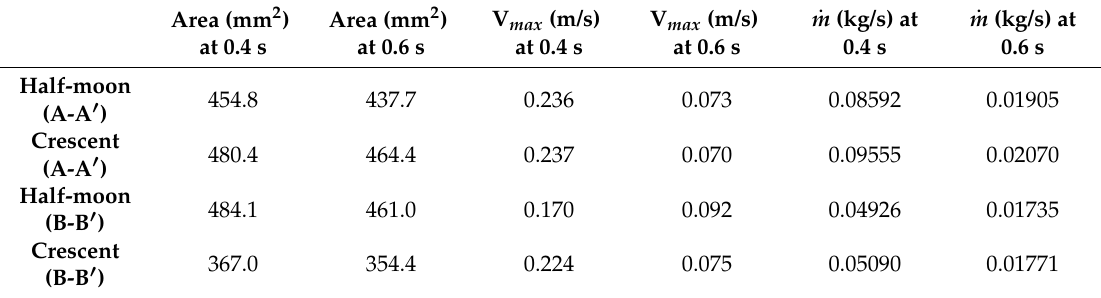
Table 2. Cross-sectional areas, maximum velocities and mass flow rates of A-A’ and B-B’ at both 0.4 s and 0.6 s.